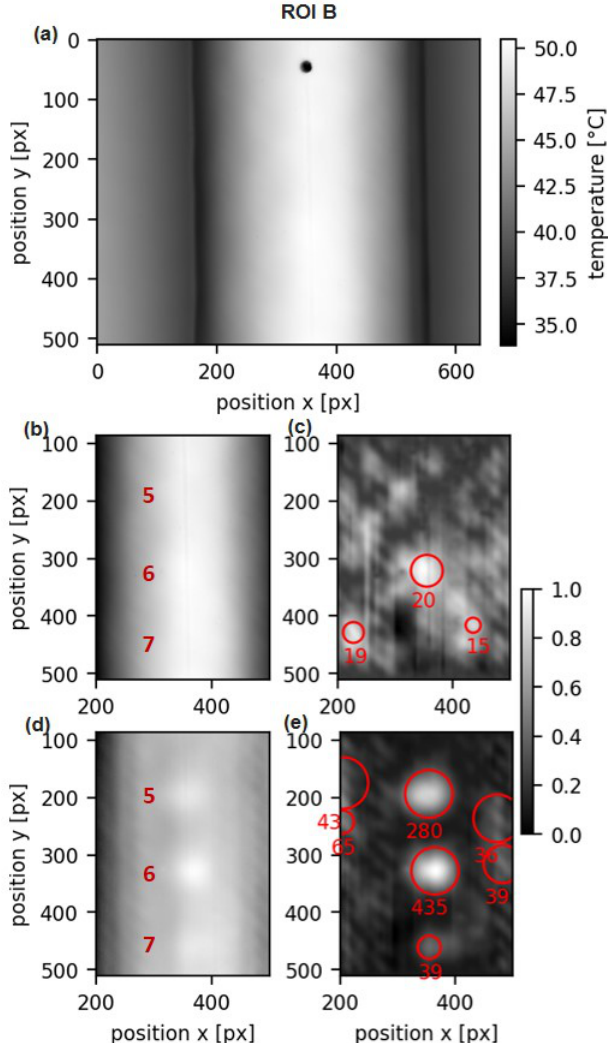
Figure 7. Results of test series 2 (ROI B, t exc = 25s, t rec = 15s, k = 89mm, ( a ) surface temperature of the whole camera FOV, ( b ) result for the reference method without filtering at t rec = 0s, ( c ) reference image with filtering, automatic defect detection and calculation of the CNR, ( d ) result for the PCA- based method without filtering, ( e ) PCA-based image with filtering, automatic defect detection and calculation of the